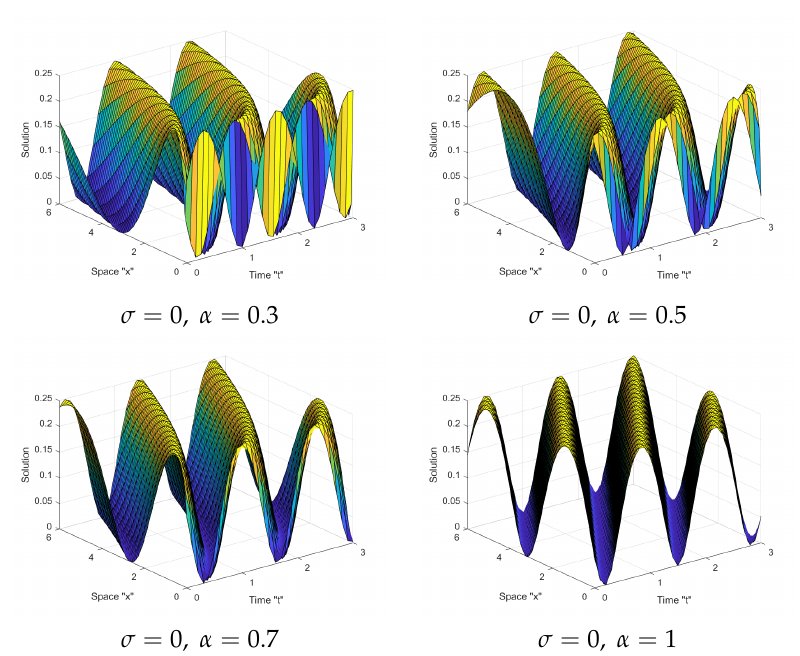
Figure 4. 3D profile of Equation (22) with σ = 0 and various α